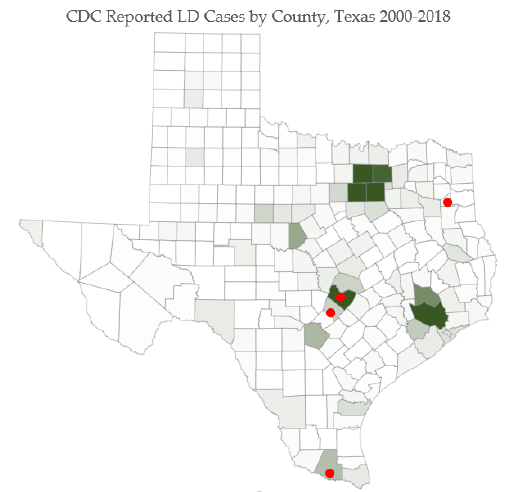
Figure 7. Human cases of LD, 2012–2018. County cases range from 0 to 179, with the darkest shades representing the counties with the highest number of cases. (Due to low case counts in some counties, data may not be provided to protect the identities of infected individuals). Figure 8 is a map of human ehrlichiosis cases from data provided from the